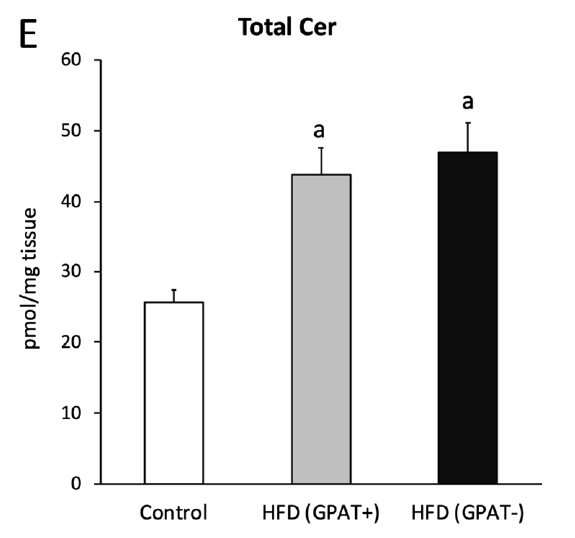
Figure 3. The impact of skeletal muscle GPAT silencing on the gene and protein expression of GPAT, and the content of bioactive lipids in gastrocnemious muscle of high-fat diet mice. Panel A and B —the expression skeletal muscle GPAT at the mRNA and protein level, respectively; Panel C —total content of diacylglycerols (DAG); Panel D —total content of triacylglycerols (TAG); Panel E —total content of ceramide (Cer). Values are mean ± SD ( n = 8); a— p < 0.05 vs. control; b— p < 0.05 vs. HFD (GPAT + ) ; significance by ANOVA; HFD—high-fat diet. * The observed molecular weight of indicated proteins is di ff erent to the theoretical one, as stated by the antibody